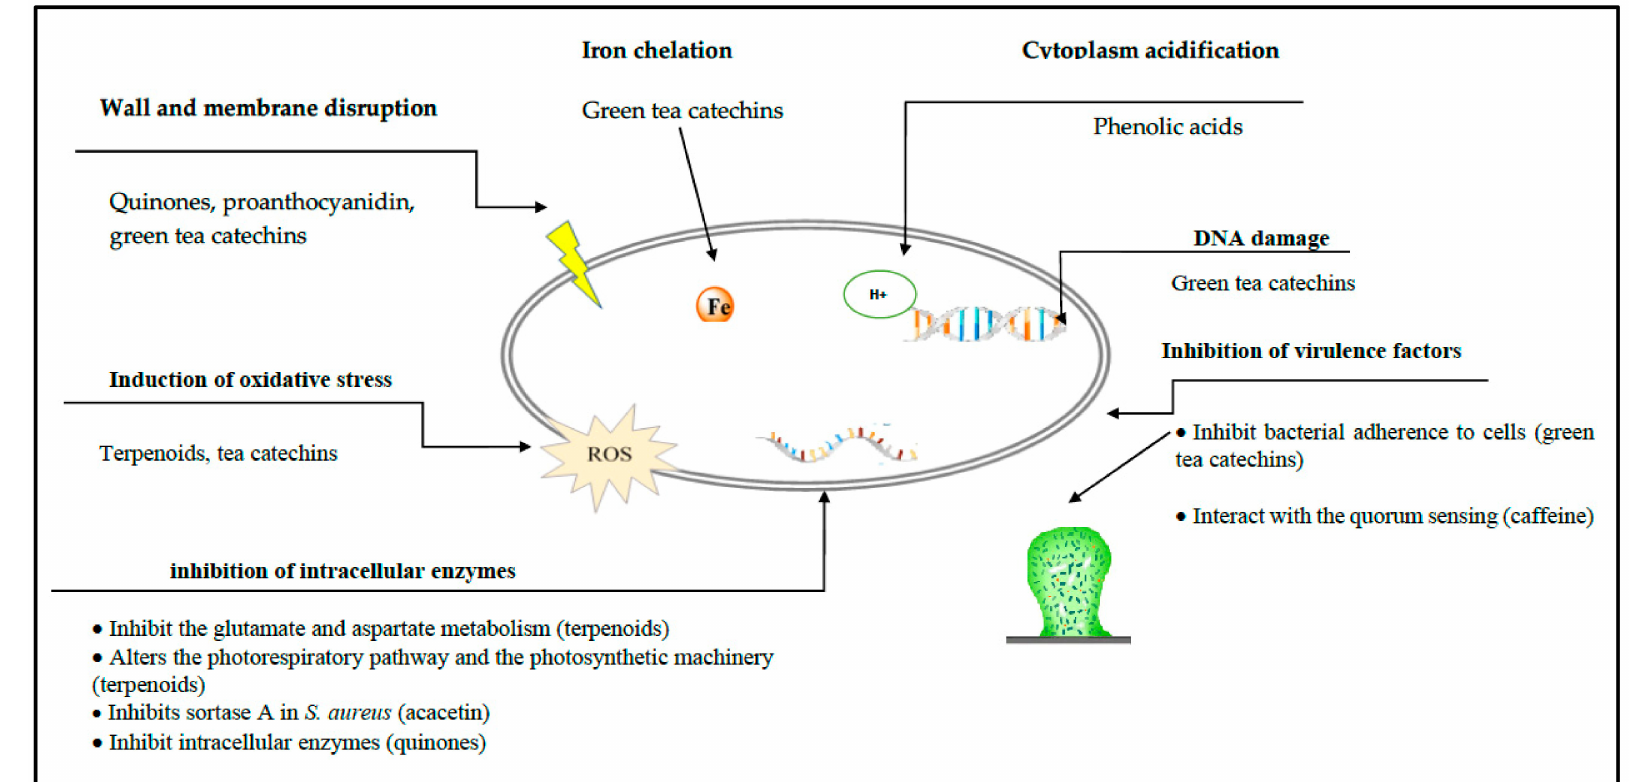
Figure 8. Antibacterial action mechanisms of plant-derived